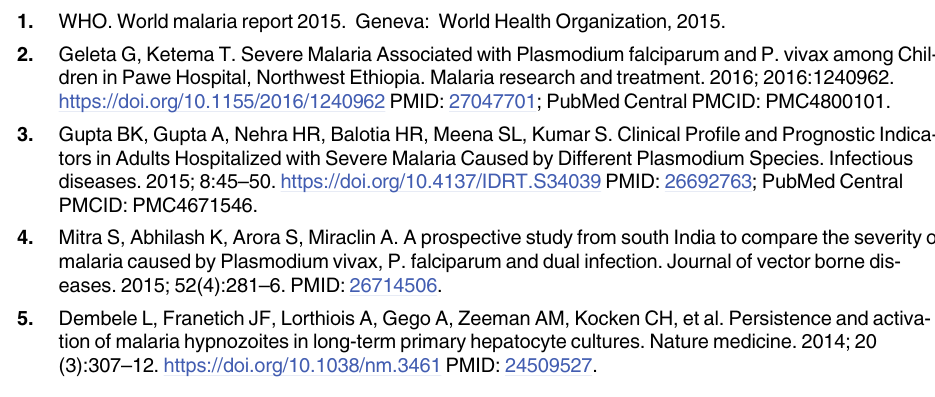
S6 Table. Association between IgG levels to P . vivax antigens and protection against P . fal- ciparum clinical disease (with parasite density > 2500/μl of blood). S7 Table. Prevalence of antibody responders to P . vivax coiled coil fragments in donors from Burkina